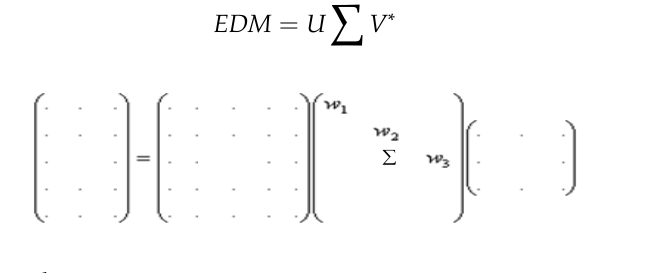
7 of 11 Right: blue dots represent the entries in the Euclidean Distance Matrix, corresponding to the neighboring sensors